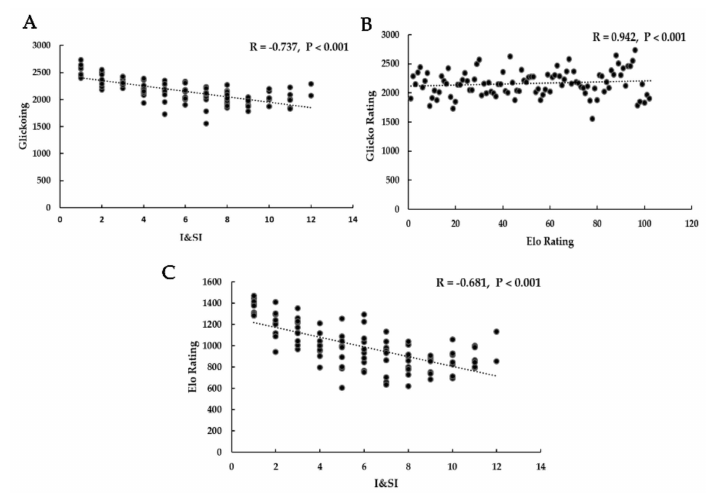
Figure 2. Spearman rank correlations between I&SI, Elo rating, and Glicko rating indices. ( A ) The linear relationship between I&SI and Glicko rating; ( B ) The linear relationship between Elo rating and Glicko rating; ( C ) The linear relationship between I&SI and Elo rating.